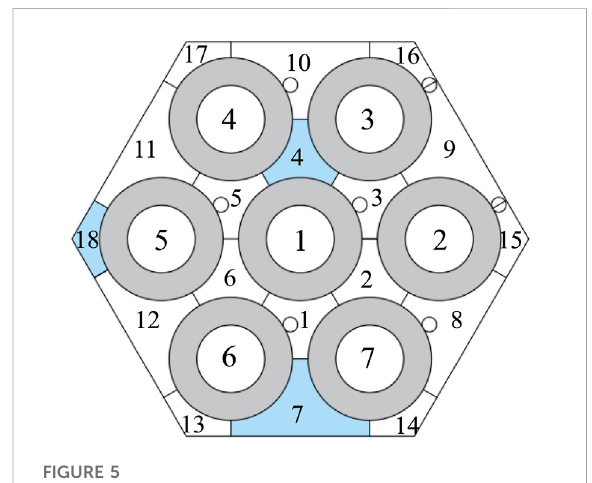
FIGURE 5 Serial number of sub-channels and inner fl ow fi